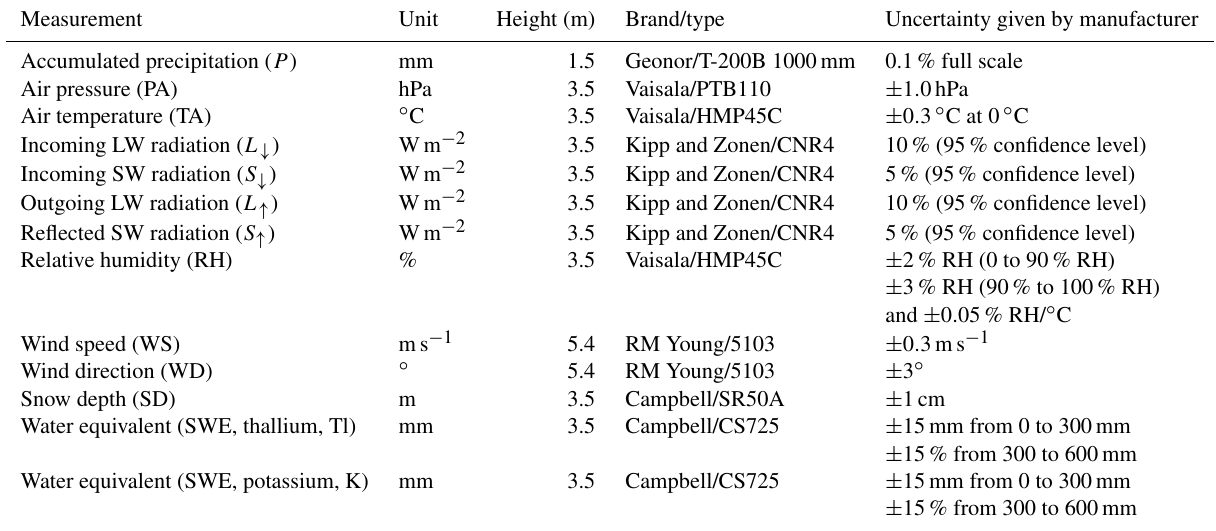
Table 1. Available observations, sensor height from the ground, and the manufacturers and type of the corresponding sensor at Tapado AWS. Measurement Unit Height (m) Brand/type Uncertainty given by manufacturer Accumulated precipitation ( P ) mm 1.5 Geonor/T-200B 1000mm 0.1% full scale Air pressure (PA) hPa 3.5